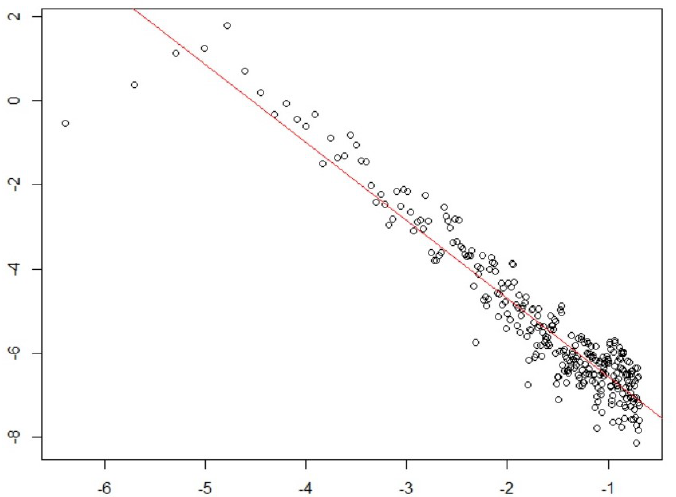
Figure 8. Log-log plot for the Welch’s periodogram of the data series with respect to frequency. The slope of the least squares line estimates the coefficient β